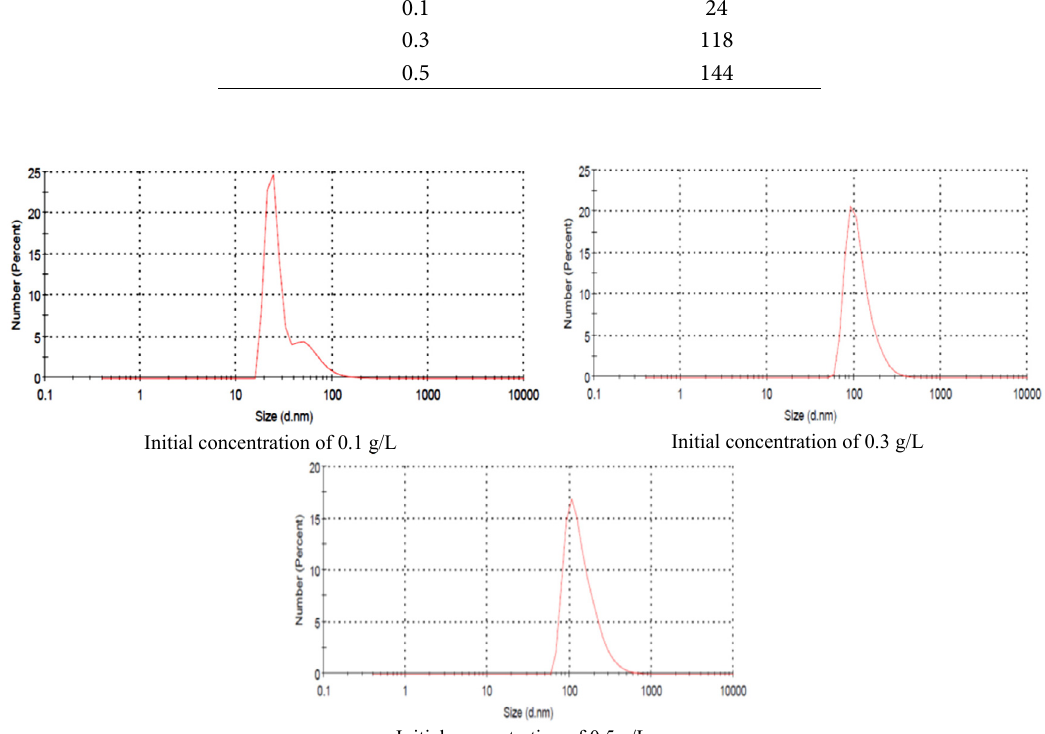
Fig. 5. Particle size distribution of lemon balm nanoparticles with different extract